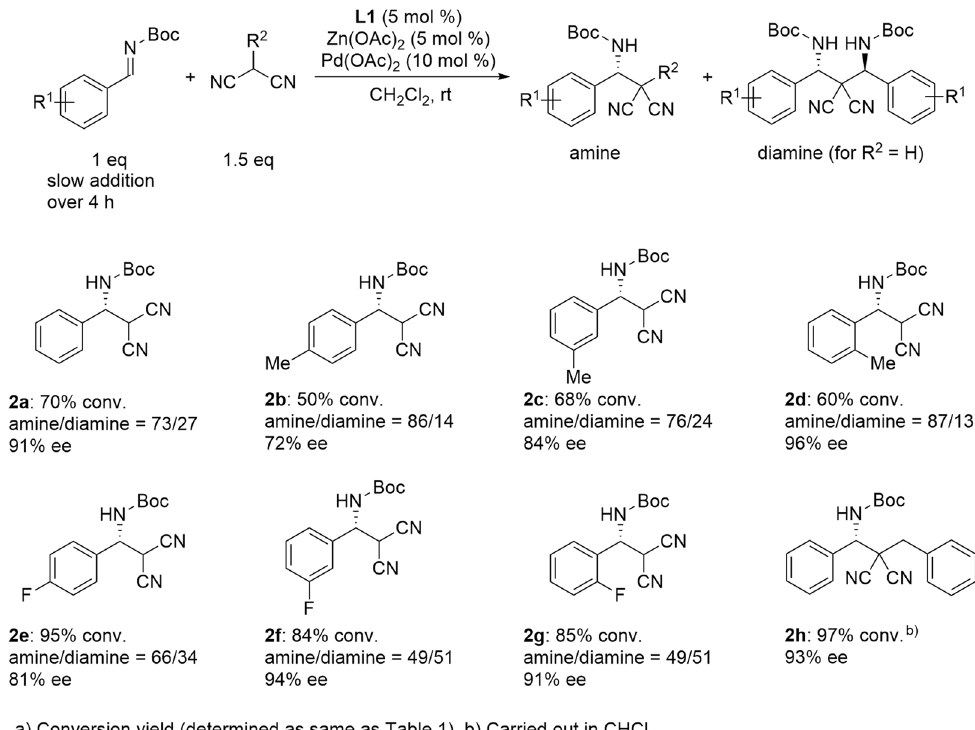
Figure 4. Dinuclear phosphoiminoBINOL-Pd catalyzed asymmetric Mannich reaction using